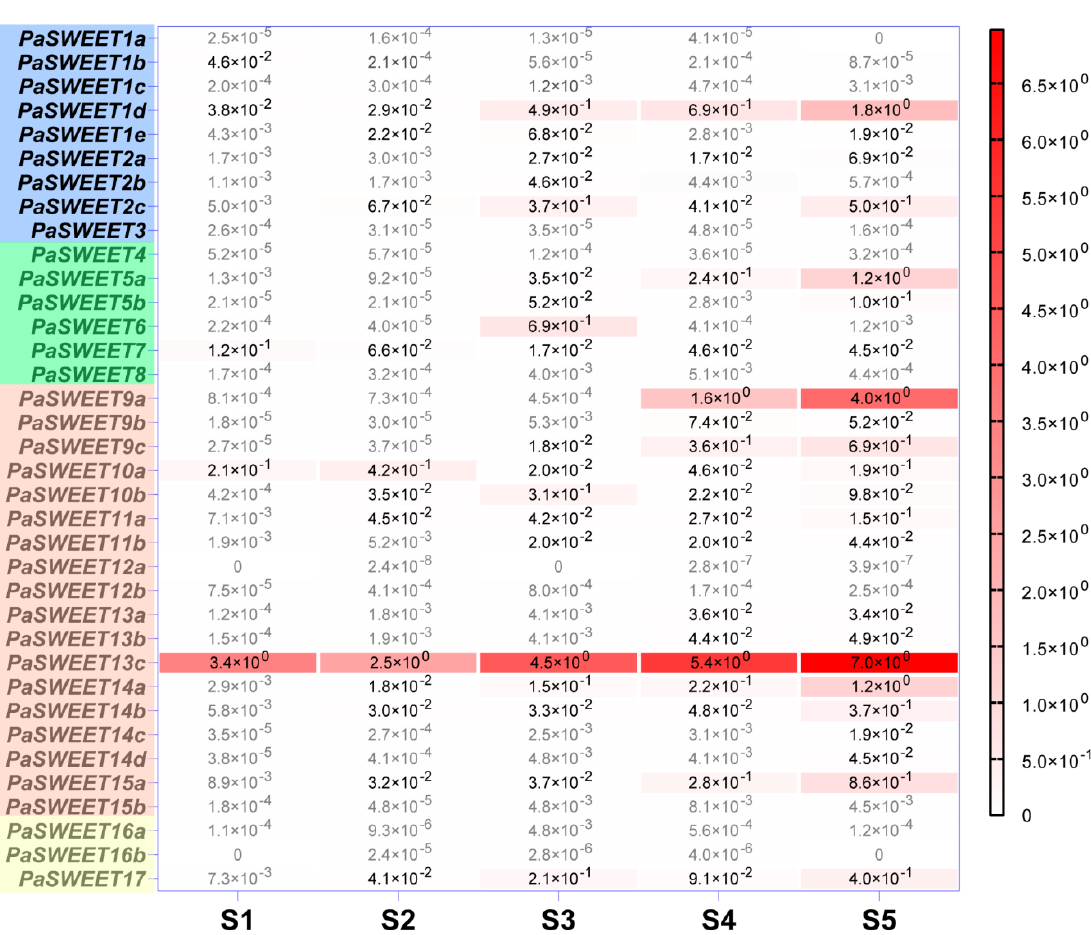
Figure 4. Quantification of 36 PaSWEET gene expression during flower development. Transcript abundance was determined via qRT-PCR using ACTIN as an endogenous reference gene. Data represent the average of three independent determinations. Each determination was run on pooled samples with 2–5 flowers. Values lower than 1.0 × 10 − 3 are depicted in grey for better visualization. The statistical parameters are provided in Table S2.